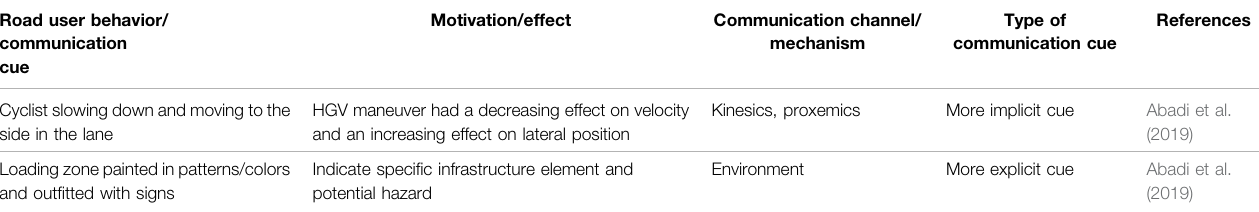
TABLE 5 | Reported interactive road user behaviors/communication cues from HGV-VRU merging scenarios, including their motivation/effect, communication channel/ mechanism, type of cue, and reference. Road user behavior/